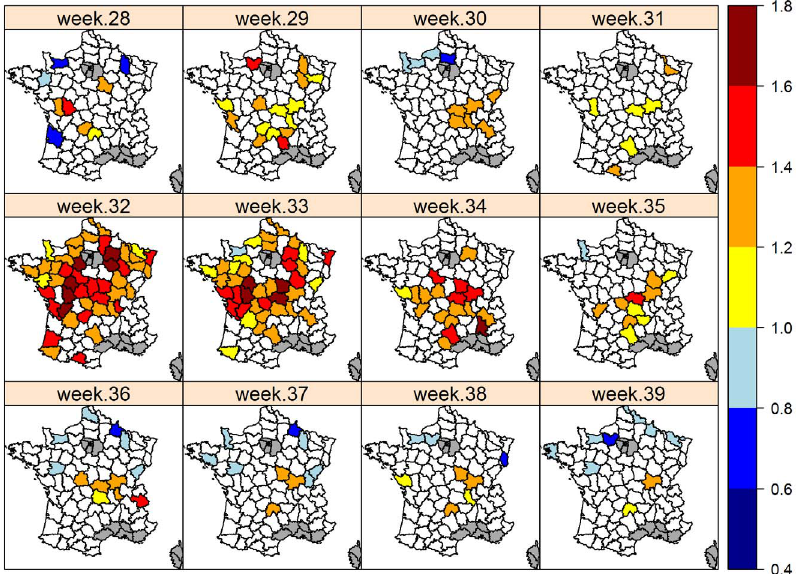
Figure 4. Geographic distribution of the weekly mortality ratio (O/E) in 2003. French departments in white correspond to departments where Observed/Expected mortality is not significantly different from 1. Mortality was not modeled in departments in gray due to the scarcity of